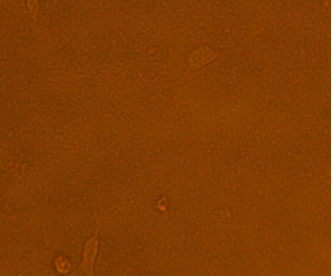
Fig. 2. The cytotoxic effect of the tested E. coli isolate on HEp-2 cells with mild detachment 2 h post infection